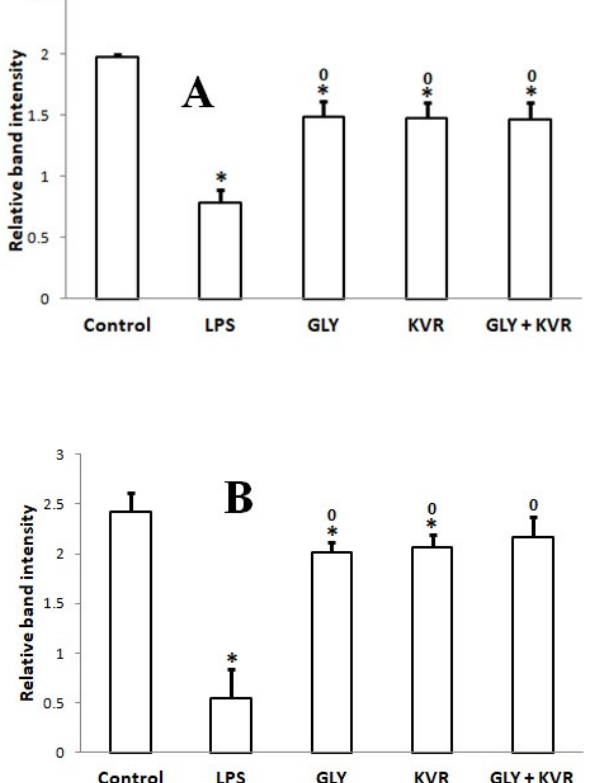
Figure 4. Expression of superoxide dismutase (SOD) and Catalase (CAT) in U937-derived macrophages (a) Ratios of intensities of (A) SOD and (B) CAT over housekeeping gene GAPDH for RT-PCR of mRNA isolated from U937-derived Macrophages. LPS, transformed cells treated with 1 µg/ml Lipopolysaccaride only; GLY, transformed cells Supplemented with Glycine (300 µM) before exposure to Lipopolysaccharide (1 µg/ml); KVR, transformed cells supplemented with Kolaviron (25 µg/ml before exposure to Lipopolysaccharide (1 µg/ml); GLY + KVR, transformed cells supplemented with both Glycine and Kolaviron (300 µM GLY + 25 µg/ml KVR) before exposure to Lipopolysaccharide. Each bar represents mean ± S.E.M of six replicates expressed as % Viability in comparison to control. *Significantly different from control; o Significantly different from LPS. p <